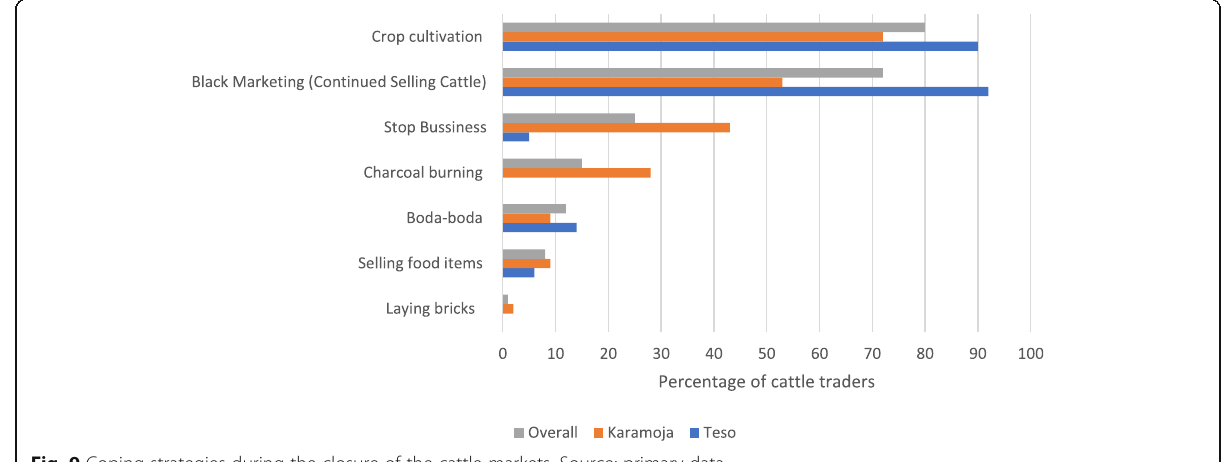
Fig. 9 Coping strategies during the closure of the cattle markets. Source: primary